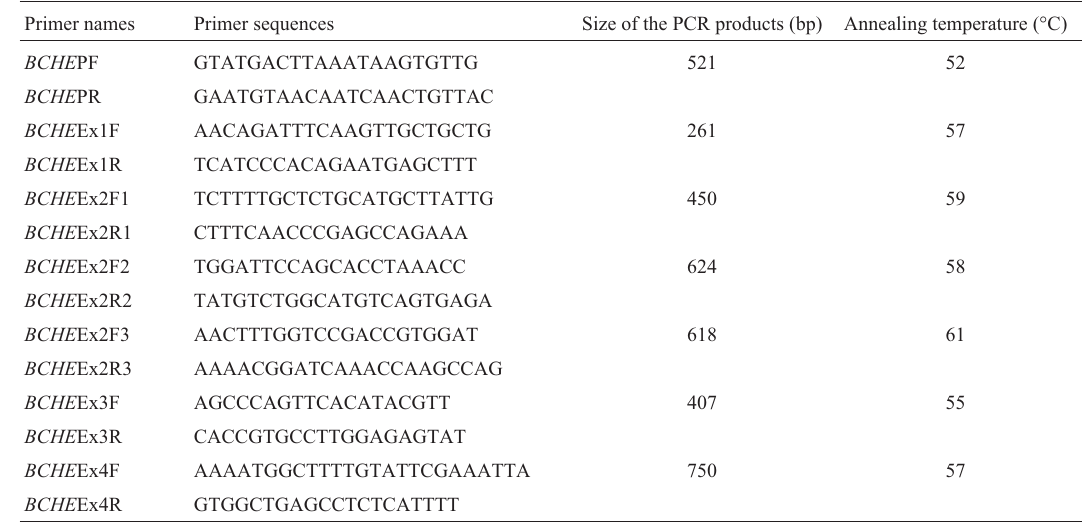
Table 2 - Primers used for amplification and sequencing of the promoter and coding regions of the BCHE